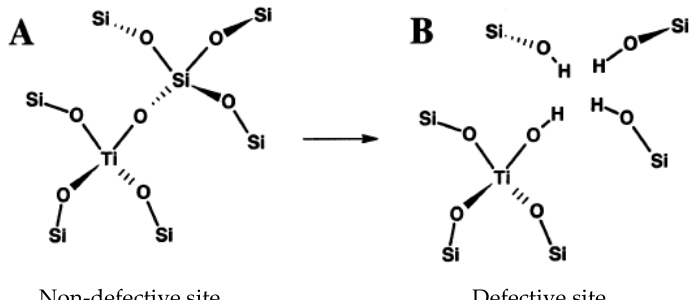
Figure 2. Schematic view of ( A ) a fully tetrahedral Ti site bonded with four O–Si groups, and ( B ) the same Ti site located near a silicon vacancy forming a silanol nest [32]. Copyright © 2004 American Chemical Society.